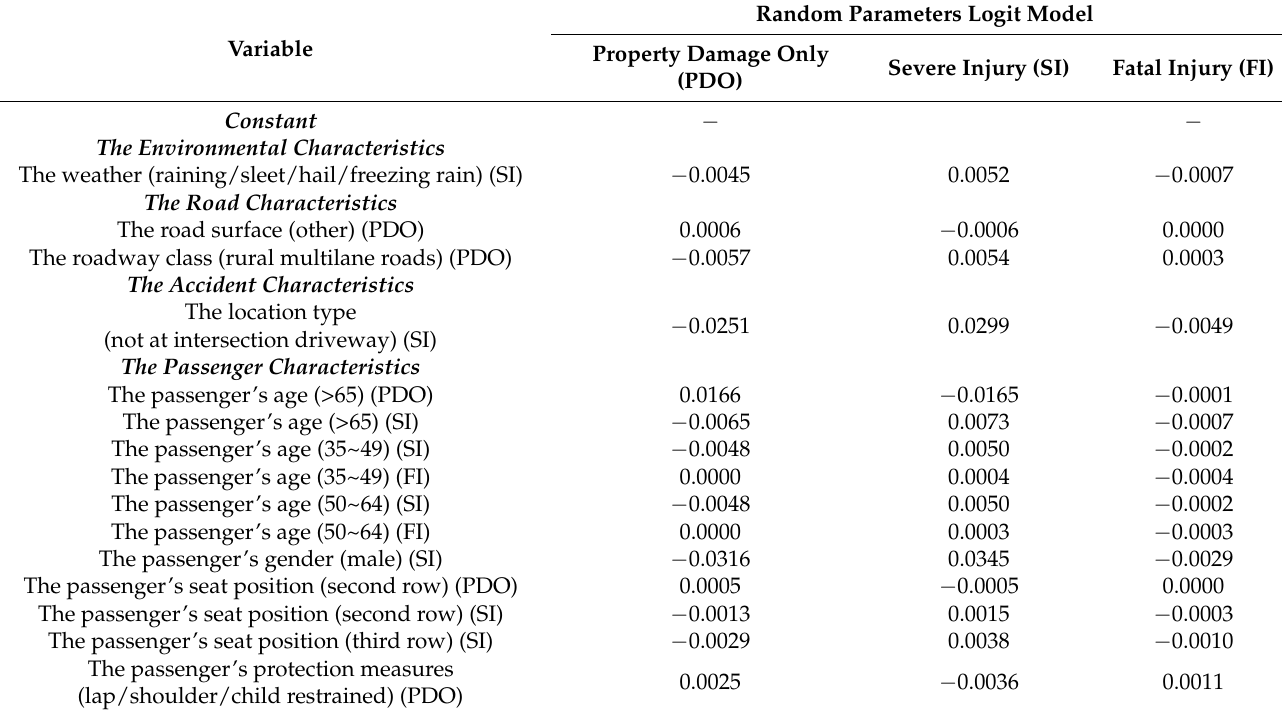
Table 6. The marginal effects of 2017 in daylight